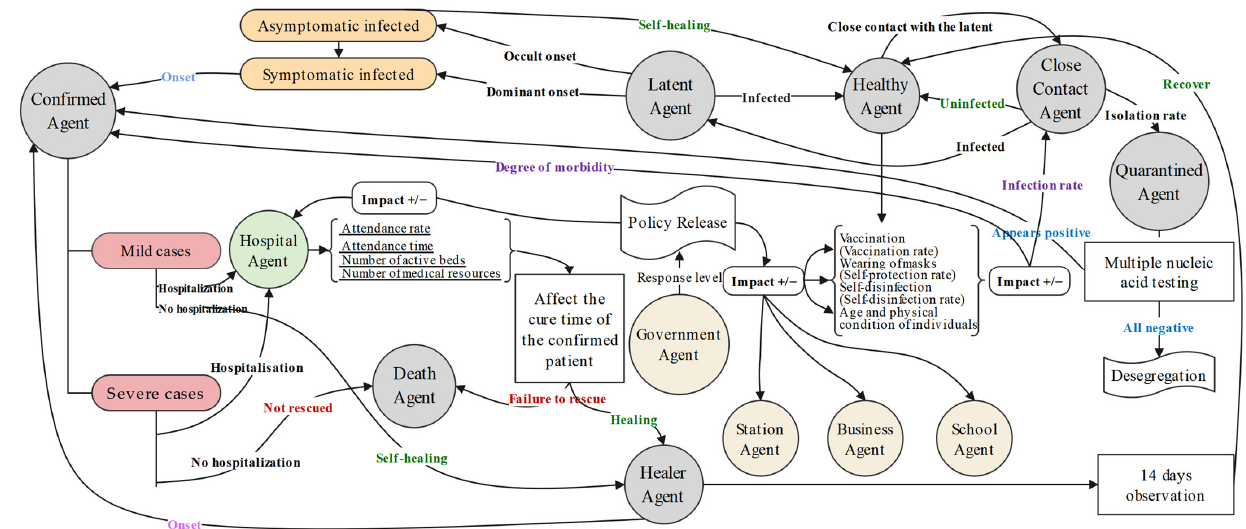
Figure 4. State transition diagram for resident agents.